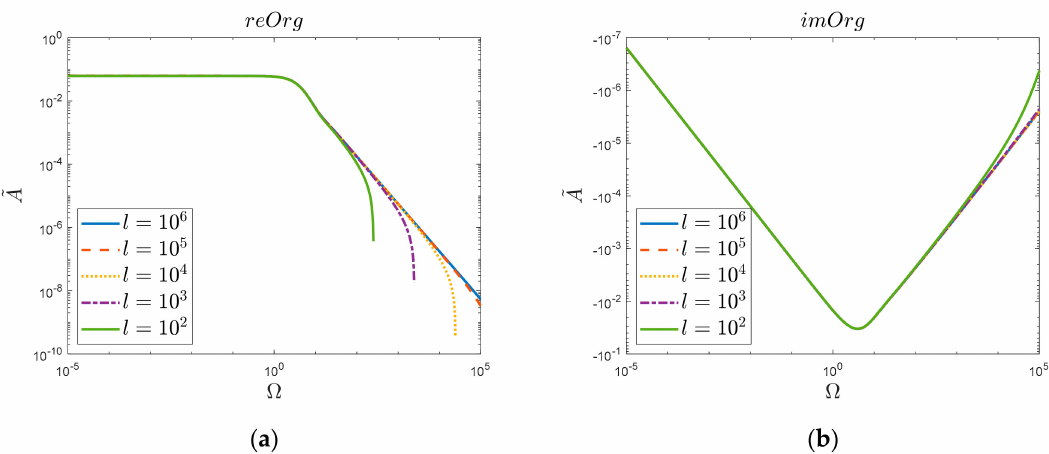
Figure 4. Dependence on the number of summation terms “ l ” of original function “ Org ”: ( a ) Realis, ( b ) Imaginaris.